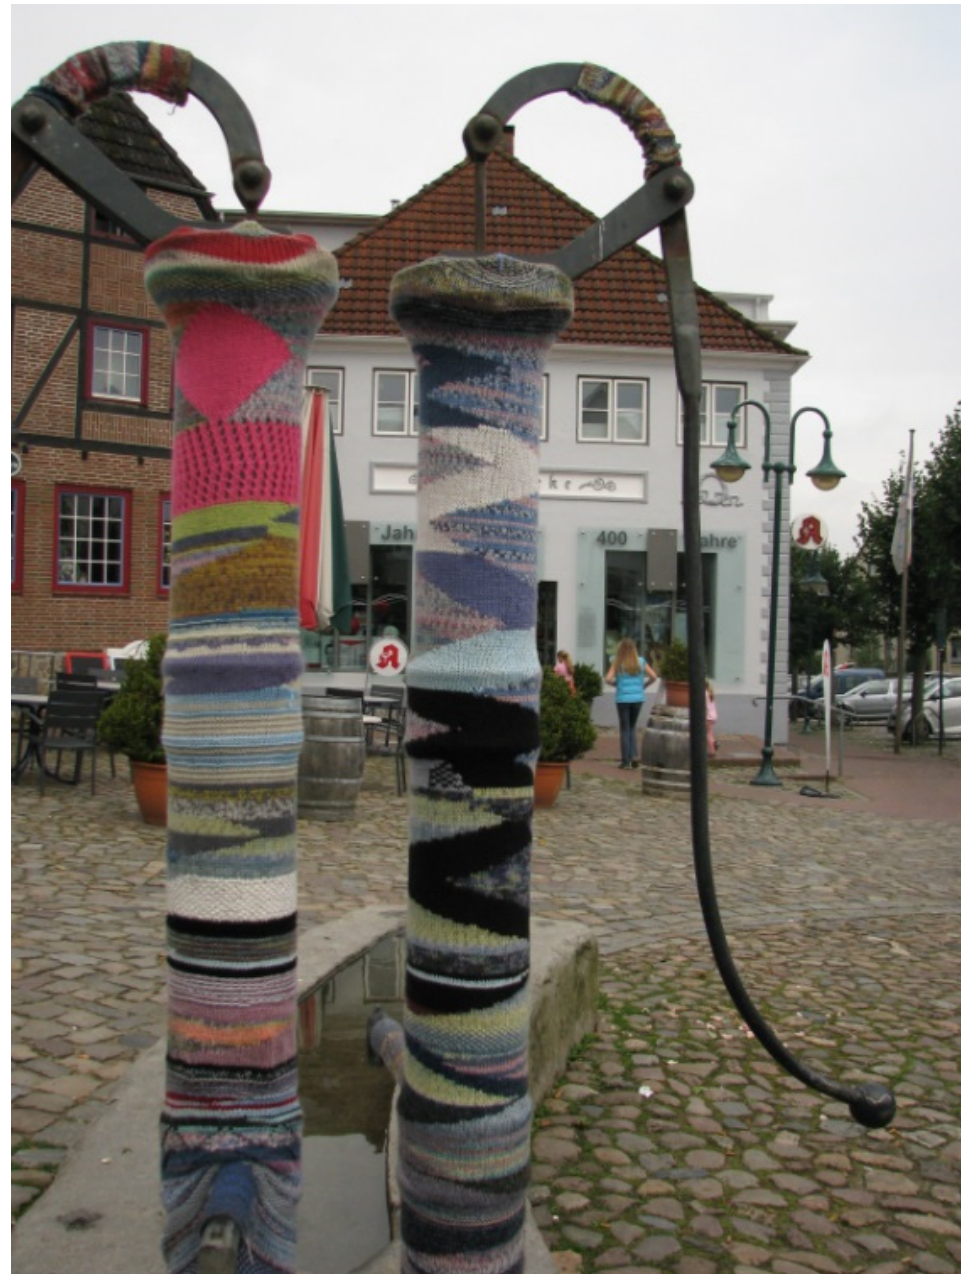
Figure 7. The water pump in Meldorf, Germany (Photo by Alicja K. Zawadzka, 20 September 2018).